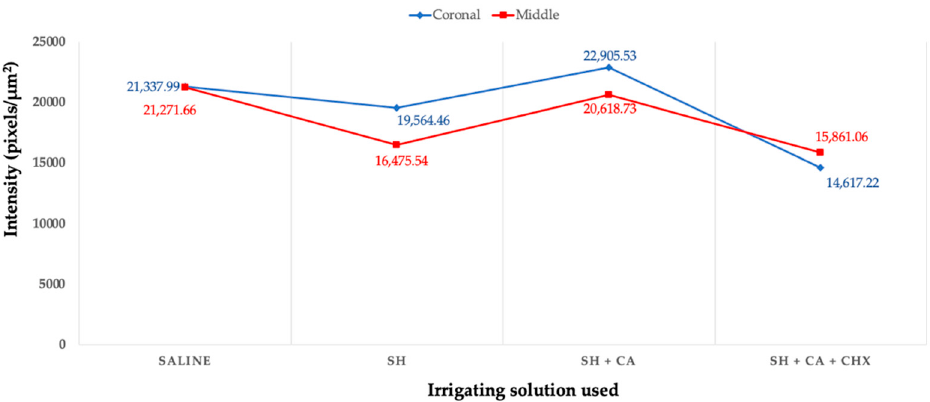
Figure 3. Line graph showing the values of gelatinolytic activity expressed as the intensity of green fluorescence in pixels/ μ m 2 in the hybrid layers of the bonded radicular dentine of different irrigating solutions. [saline, sodium hypochlorite (SH), citric acid (CA), and chlorhexidine (CHX)].